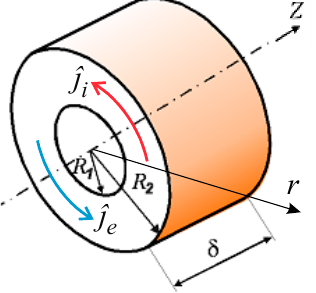
Figure 2. The plasma ring in the cylindrical coordinate system which is accelerated in the device shown in Figure 1. Here, R 1 and R 2 are the inner and the external radii of the plasma ring; δ is the ring length.